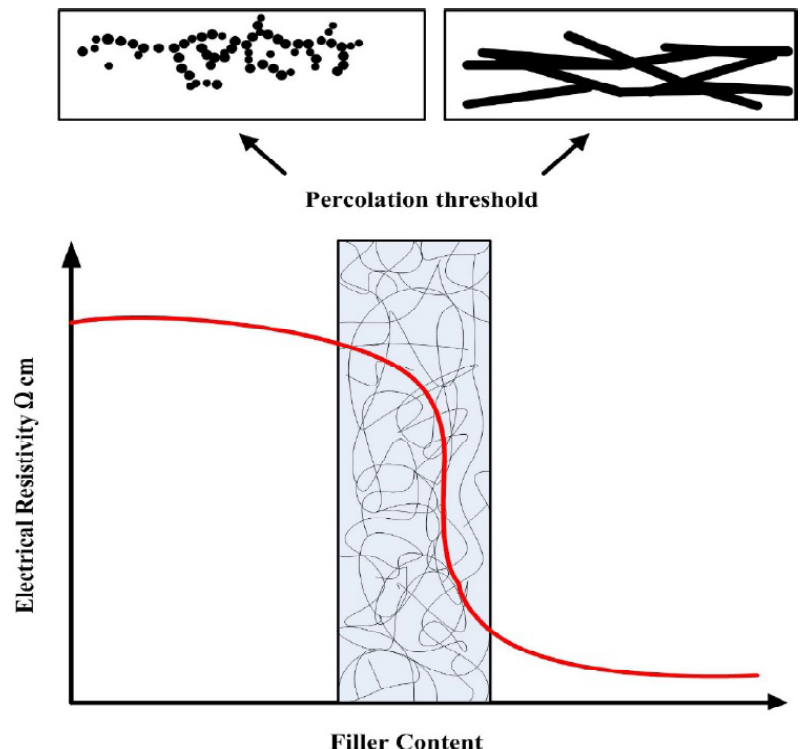
Fig. 6. Polymer resistivity relative to conductive filler content (Redrawn and adapted figure from [84]).